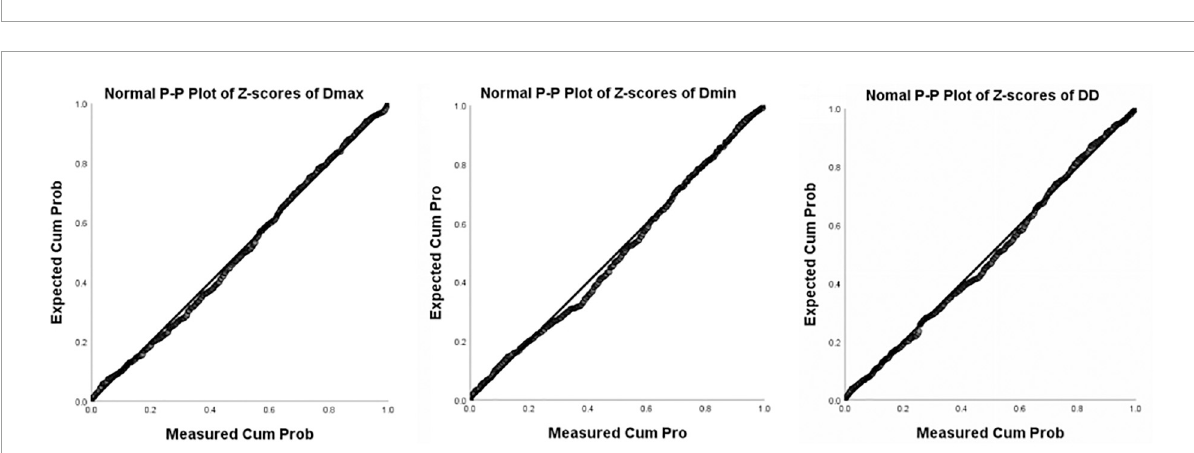
FIGURE2 P-P Plot of residuals of Dmax, Dmin, and DD (Diameter Distensibility) based on gestational age.